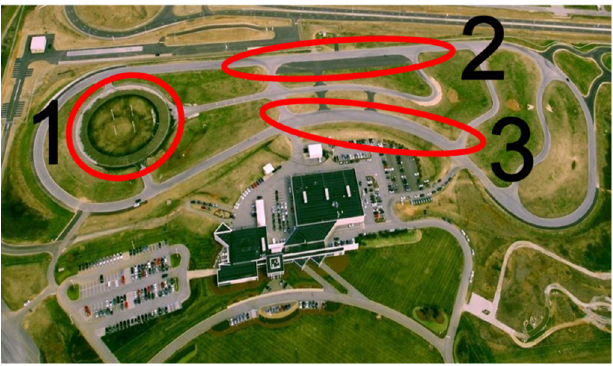
Figure 1. Aerial view of the track with the locations of the (1) skid recovery, (2) ABS braking, and (3) distraction exercises indicated.